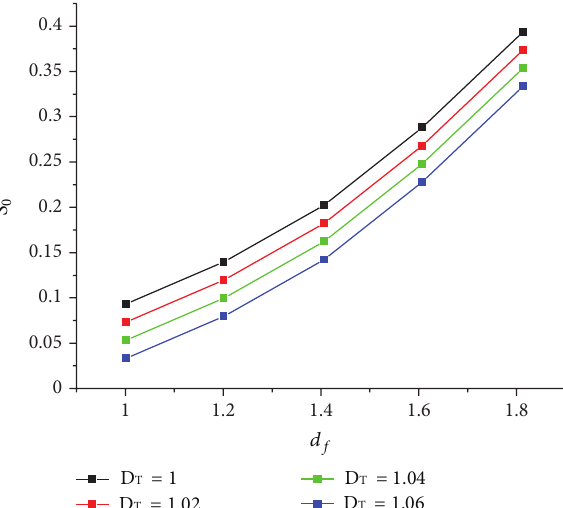
Figure 4: The new relations for 𝑆 0 and 𝑑 𝑓